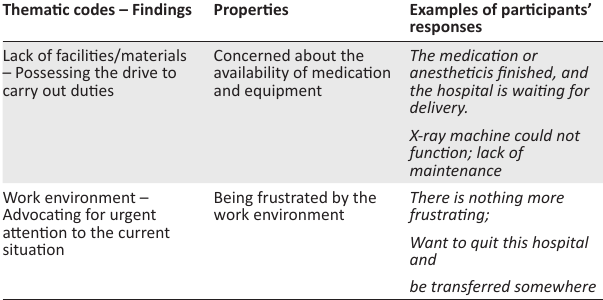
TABLE 5: Thematic codes from focus group responses regarding availability of medication and